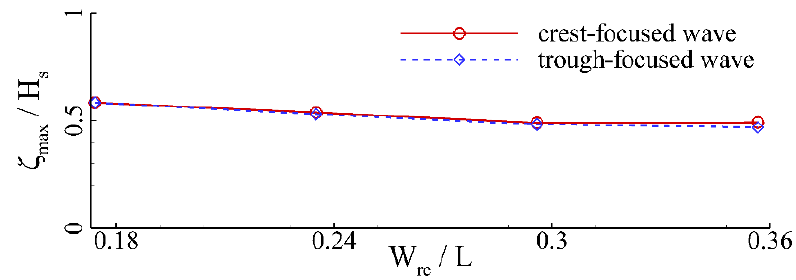
Figure 56. Maximum water elevation at the reef crest versus the ridge width.